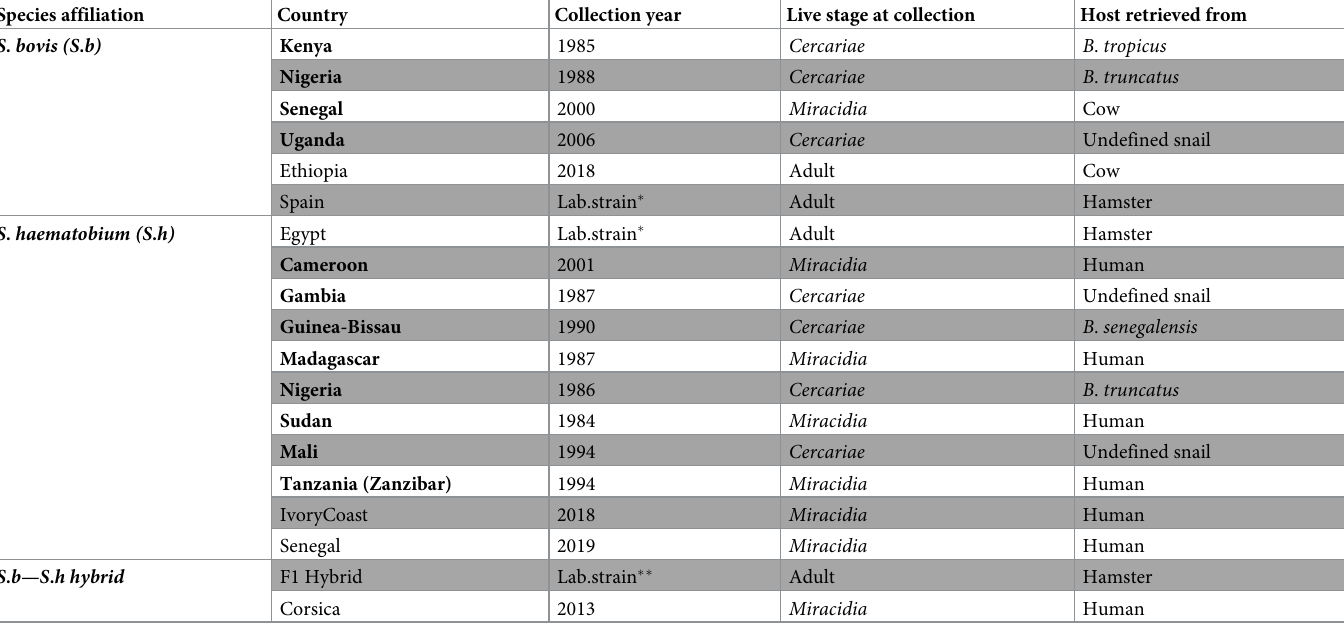
Table 1. Sample information. Samples from countries in bold were obtained from SCAN